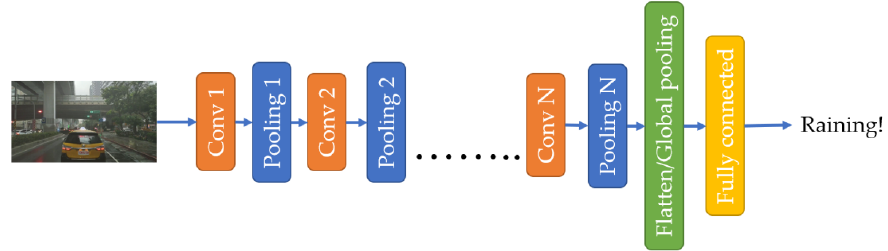
Figure 8. Operation of the convolutional neural network classifier.